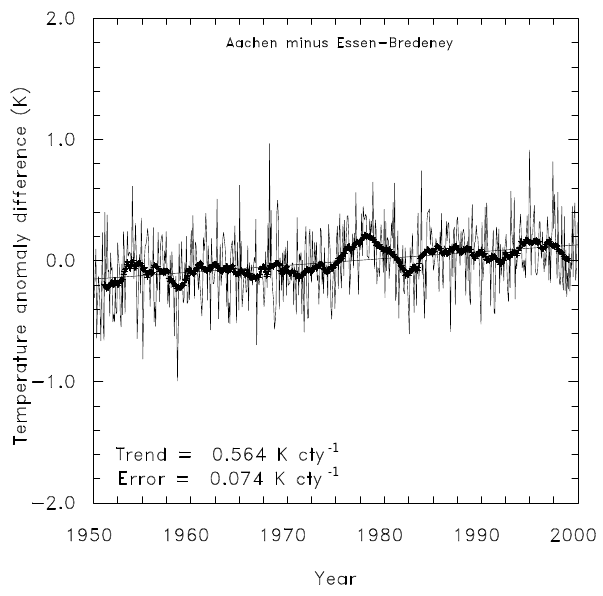
Figure 1. Difference time series of the monthly temperature anomaly between stations Aachen and Essen. The two stations are separated by 92km and their correlation coefficient for monthly means is 0.989. The thick line denotes the 2-year running mean; the thin line is the linear trend. The error variance of the trend as- suming (probably erroneously) independent data is calculated by (cid:0) 1 − r 2 (cid:1) 2 y = σ σ 2 for data on the y axis and time on the x axis, trend σ 2 x ( n − 2) while r denotes the correlation between data and time and n the